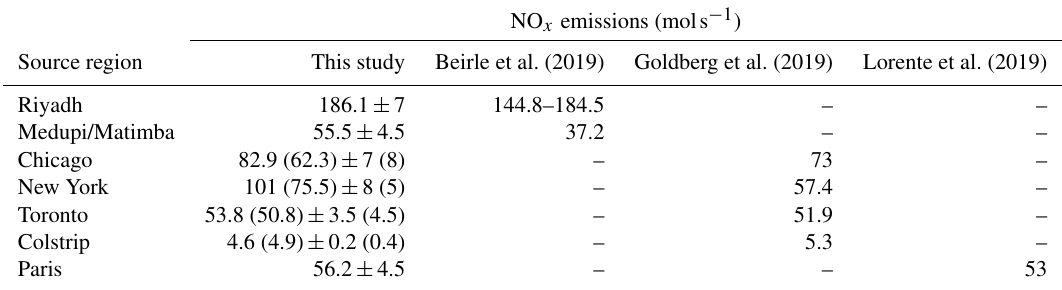
Table 1. NO x emissions estimated for seven source regions are compared to the emissions derived from other studies using TROPOMI data. Values in parentheses are derived for the same data period as in Goldberg et al. (2019). Errors are 1 standard deviation derived by the EMG fitting